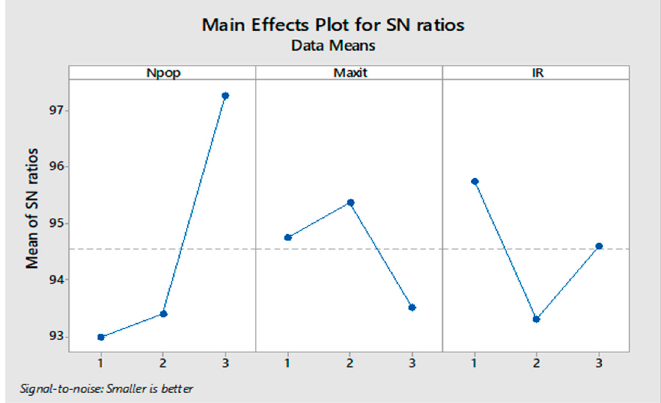
Figure 15. Signal to noise plot of MOPSO.